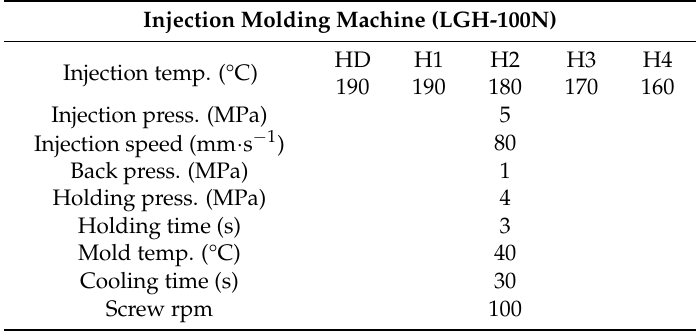
Table 3. Injection molding machine